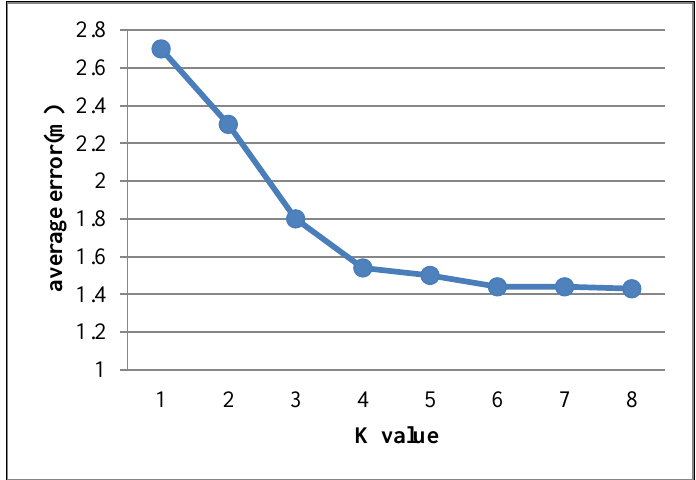
Figure 10. Average error of different K value.